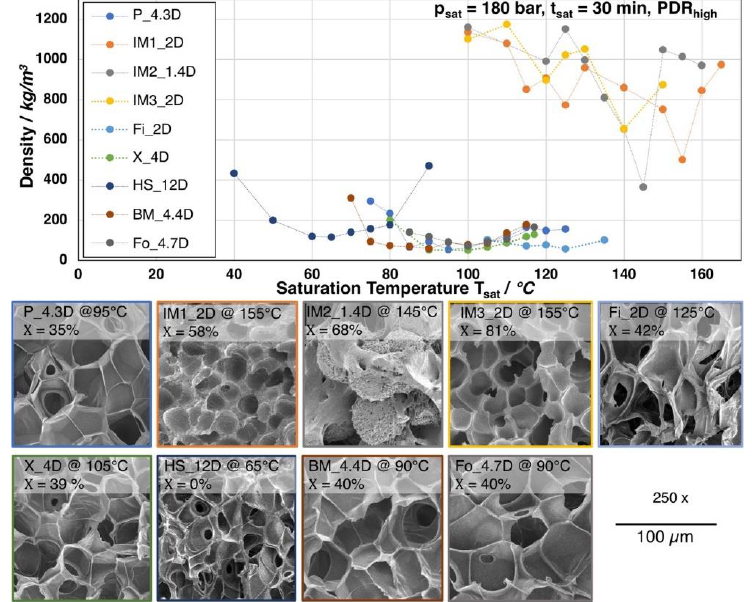
Figure 6. Top: Foam densities of the neat PLA grades foamed after a 30 min. saturation with CO 2 at 180 bar at varying temperatures. Bottom: SEM images of the foam with lowest density for each grade with crystallinity values (1 st heating).